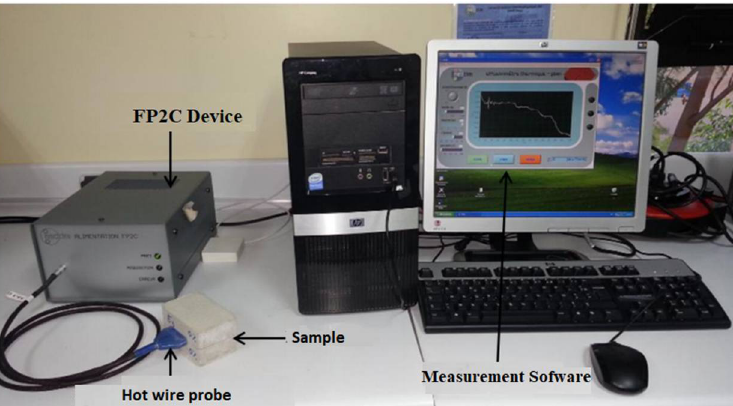
Figure 7. FP2C device used to measure thermal conductivity and thermal effusivity of the studied samples.